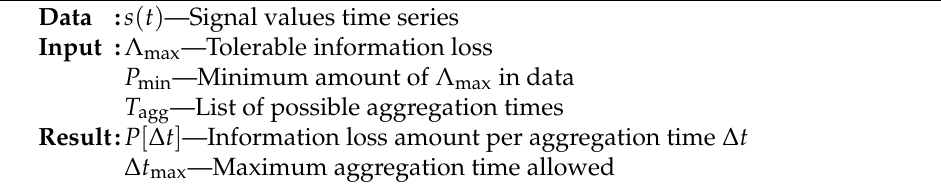
Algorithm 1: Determination of the maximum aggregation time allowed for a prechosen tolerable information loss of a